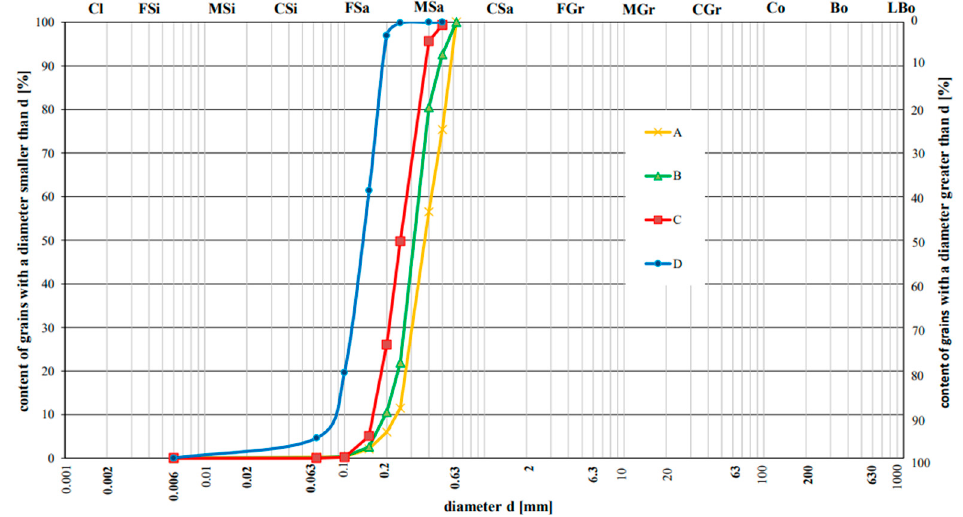
Figure 3. Grain size distribution of quartz sands used in the experiment A: d 50 = 0.38; B: d 50 = 0.32; C: d 50 = 0.25; D: d 50 = 0.14.